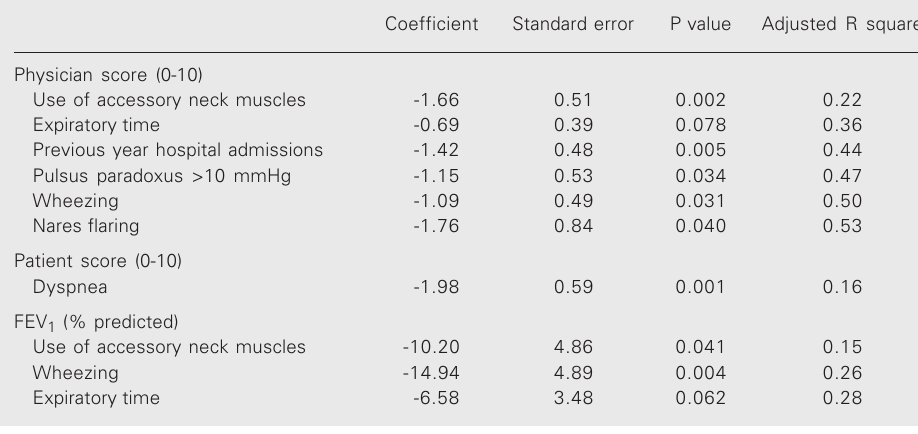
Table 3. Final stepwise regression models using physician score, patient score, and forced expiratory volume at the first second (FEV 1 ) as dependent variables.